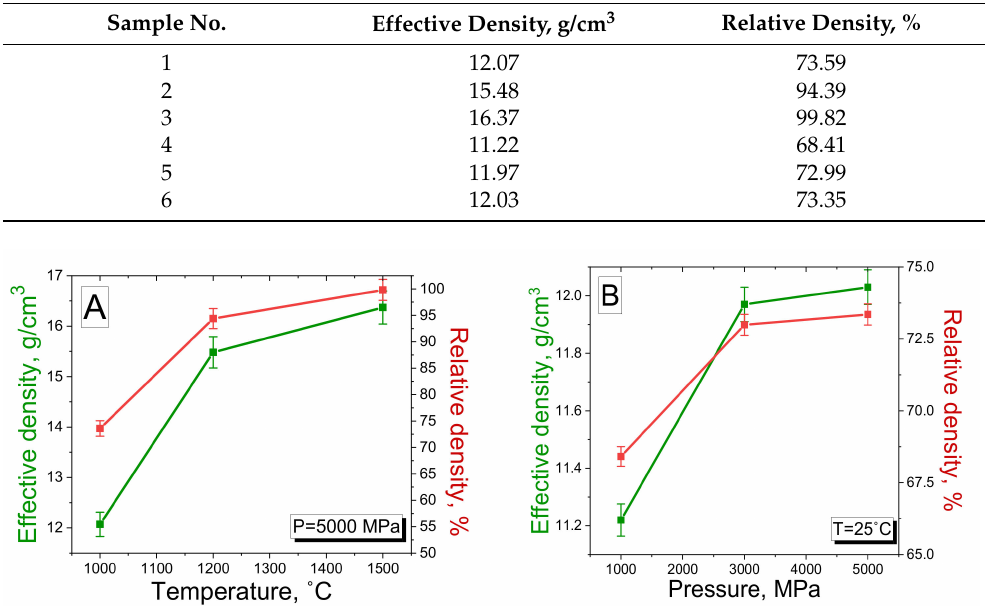
Figure 8. The dependence of effective and relative densities of the W–Cu composite on temperature ( A ) and pressure ( B )